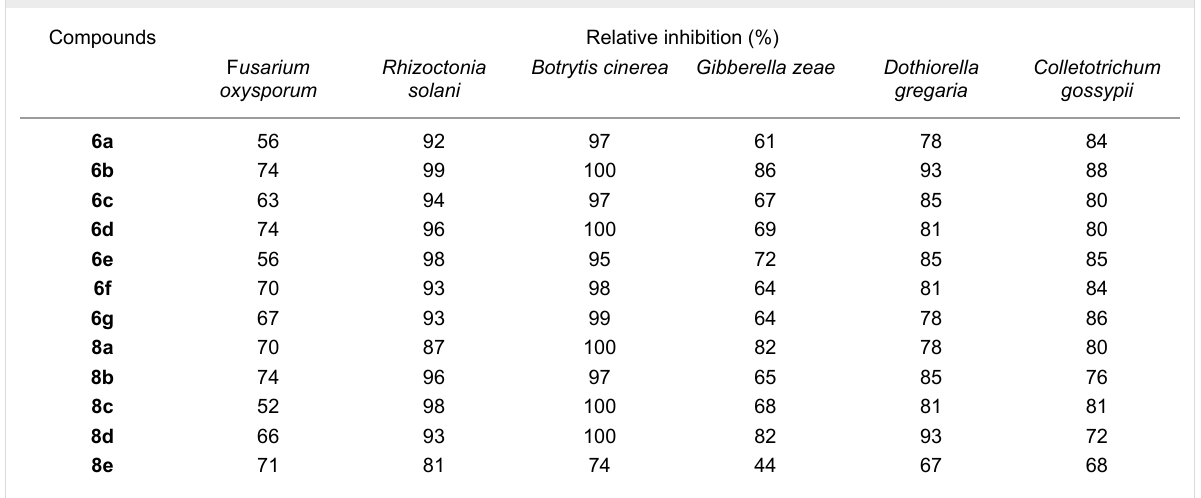
Table 2: The fungicidal activities of compounds 6 and 8 (50 mg/L).